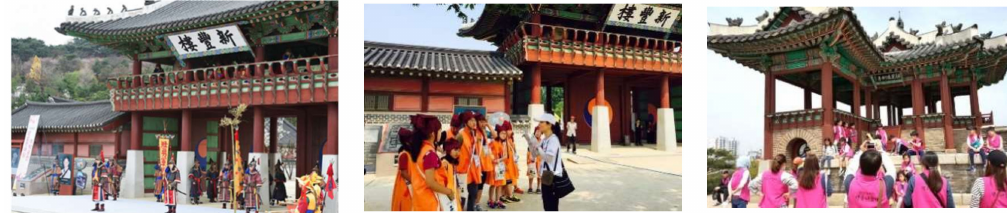
Figure 1. Hwaseong Fortress as a child-friendly place. (Source Indication: [SUWON CITY], [Visit Suwon (http: // suwon.go.kr / visitsuwon)]).